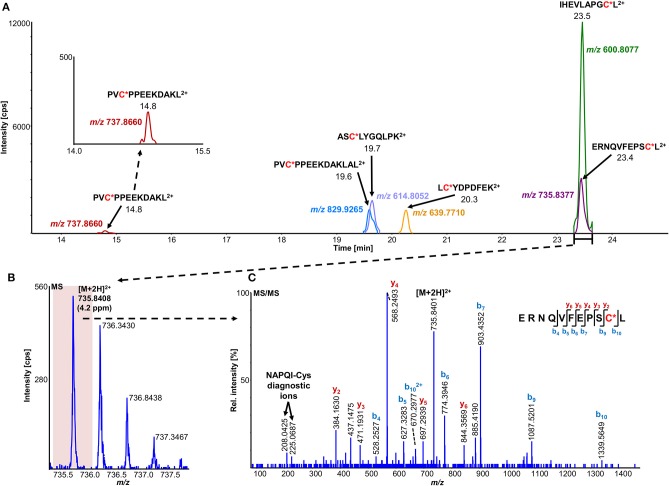
Overlaid high-resolution extracted ion chromatograms (±0.01 u) of detected modified peptide precursors (A). Confirmation was based on high-resolution accurate mass TOFMS (B) and triggered (DDA) MS/MS (C) analyses, including diagnostic NAPQI-cysteine fragment ions.